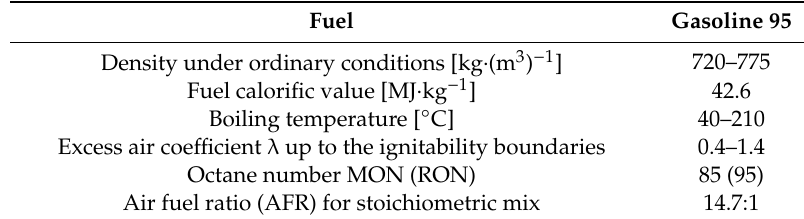
Table 2. Properties of tested fuels, where MON: research octane number; RON: motor octane number